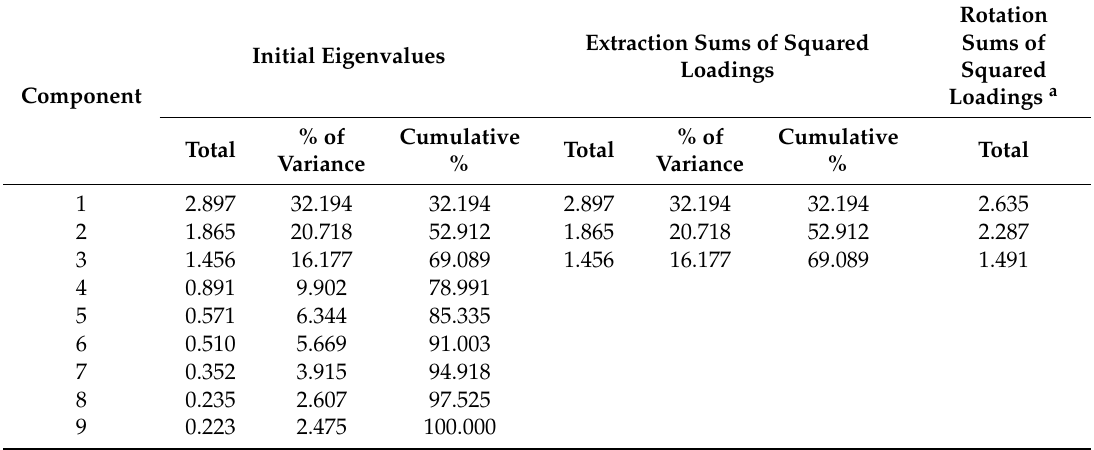
Table A5. Total Variance Explained.